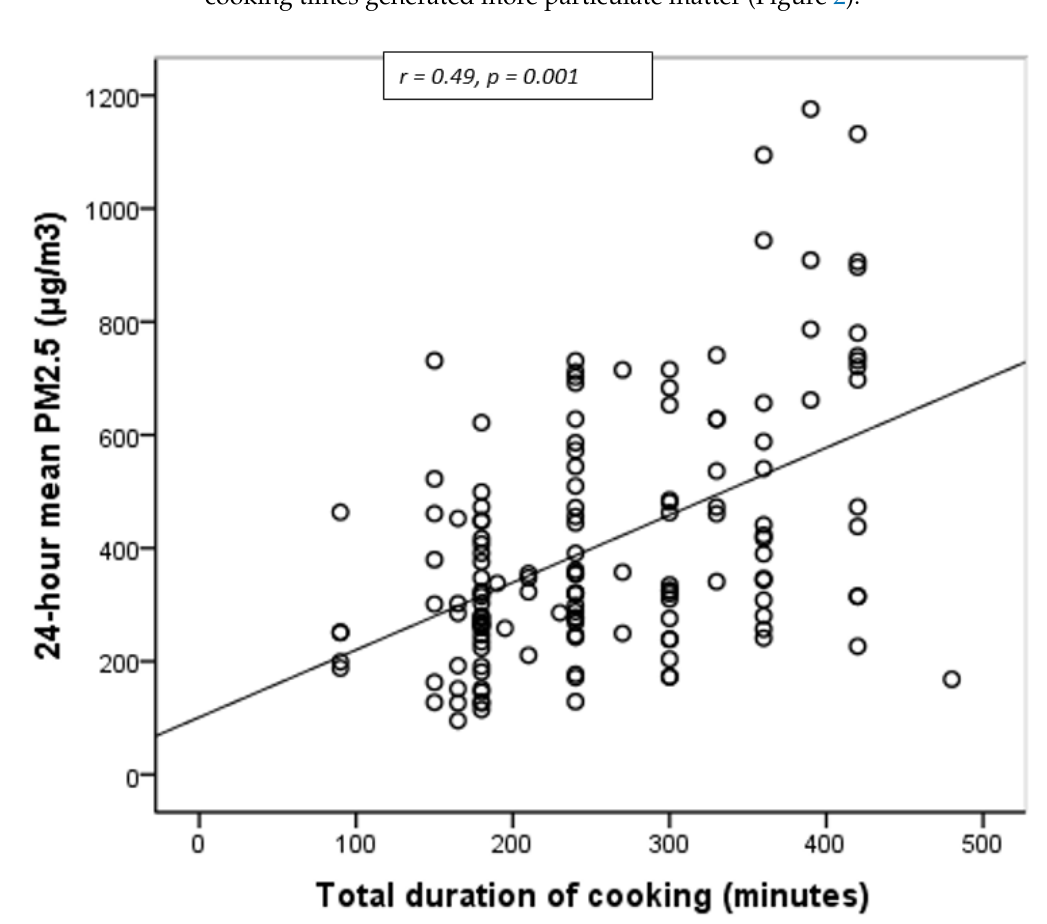
Figure 2. Correlation between 24-h mean PM 2.5 ( µ g/m 3 ) and total duration of cooking (minutes) determined in 147 house- holds in rural Butajira, Ethiopia.